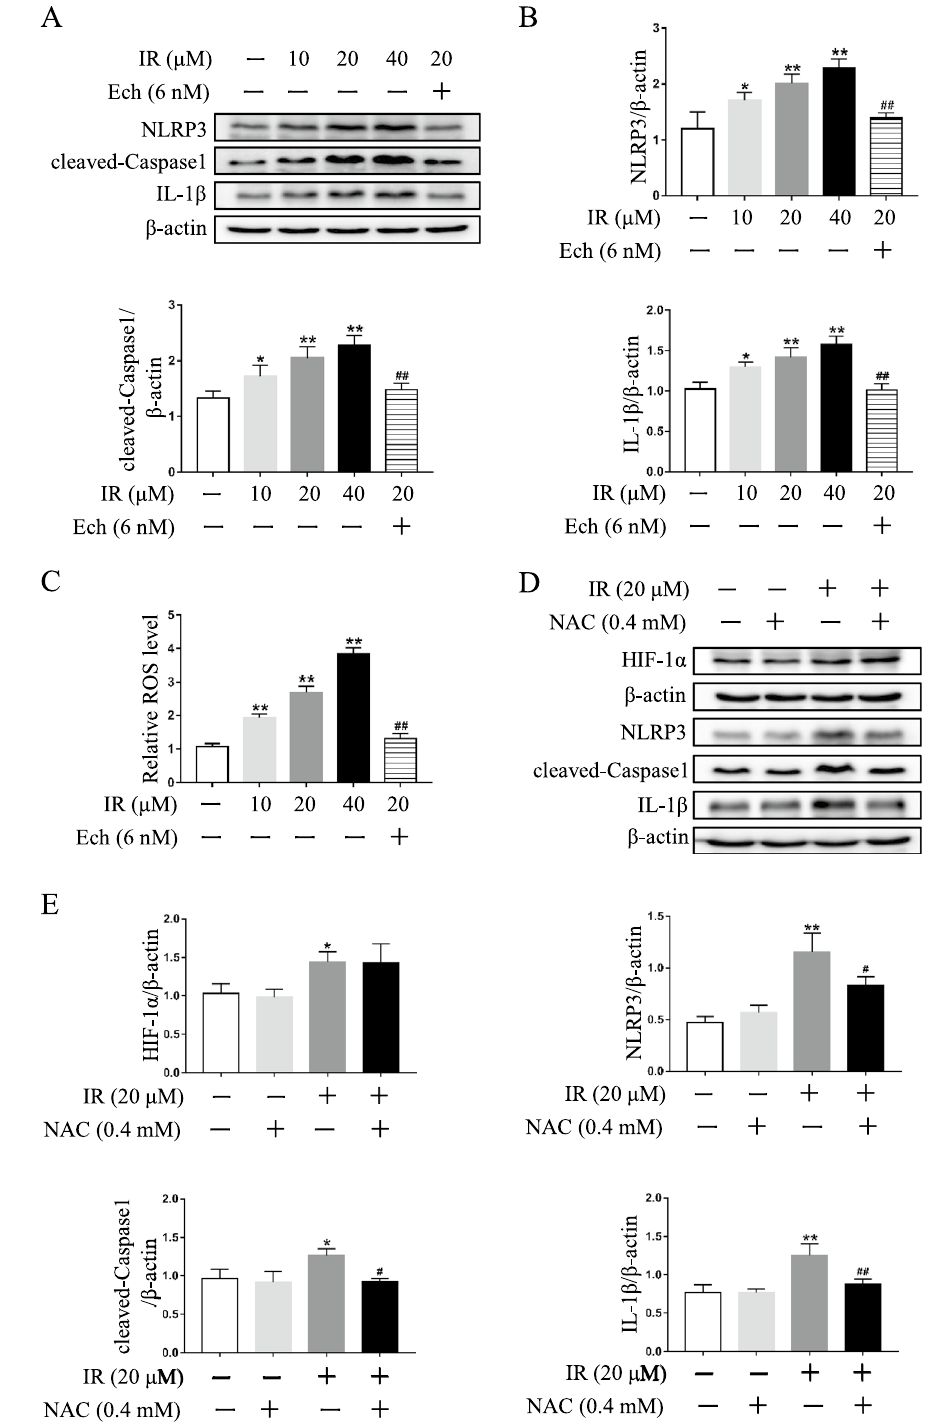
Figure 7. HIF-1α is involved in the activation of NLRP3 inflammasome in irinotecan (IR)-treated HepG2 cells. ( A ) Echinomycin (Ech) treatment suppresses NLRP3 inflammasome activity in IR-treated HepG2 cells. Western blot analysis of NLRP3, cleaved-Caspase1 and IL-1β protein levels in HepG2 cells. ( B ) Densitometric quantification of NLRP3, cleaved-Caspase1 and IL-1β. ( C ) Ech treatment alleviates ROS production in IR-treated HepG2 cells. Relative ROS level in each group. ( D ) Effects of ROS production on HIF-1α and NLRP3 inflammasome activity in IR-treated HepG2 cells. Western blot analysis of HIF-1α, NLRP3, cleaved-Caspase1 and IL-1β protein levels in HepG2 cells. ( E ) Densitometric quantification of HIF-1α, NLRP3, cleaved-Caspase1 and IL-1β. The blots were cut prior to hybridization with indicated primary antibodies. Data are presented as mean ± SD (n = 3), * P < 0.05 and ** P < 0.01 compared with normal control group, # P < 0.05 and ## P < 0.01 compared with 20 μM IR-treated